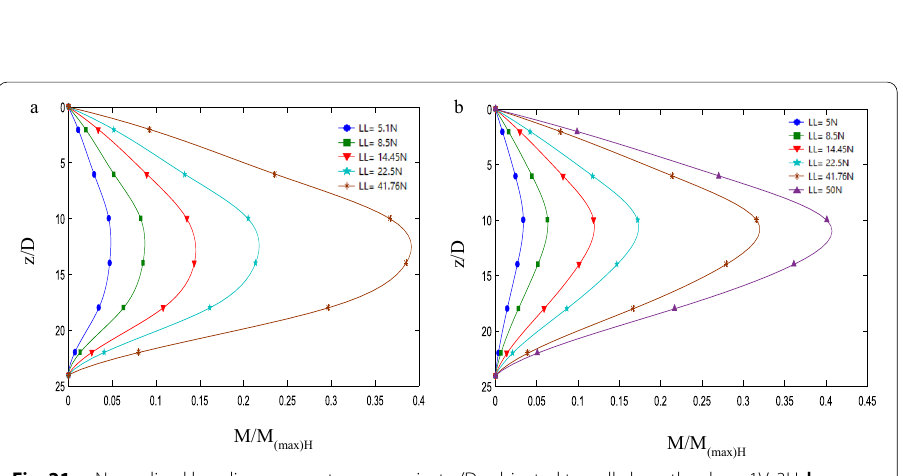
Fig. 20 a Normalized bending moment curve against z/D subjected to pull along the slope 1V: 2.5H. b Normalized bending moment curve against z/D subjected to pull against the slope 1 V: 2.5H